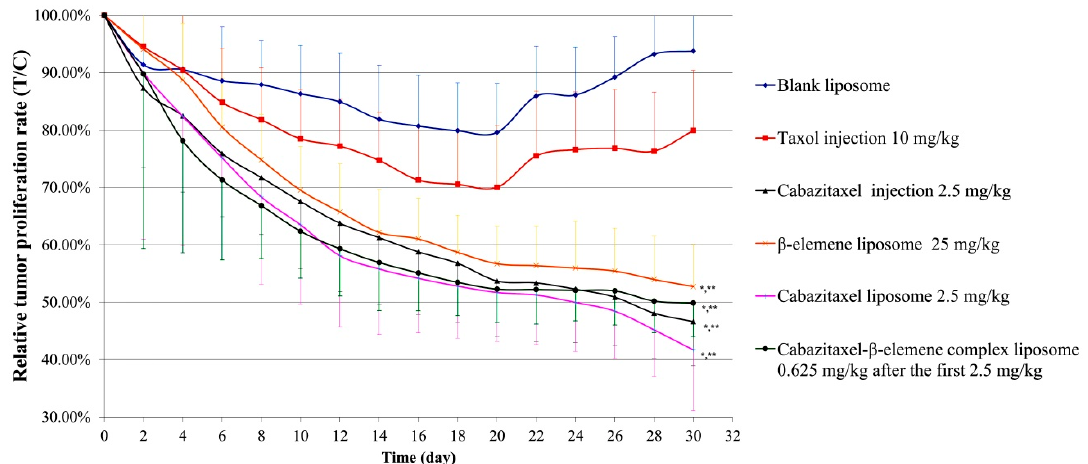
Figure 3. The relative tumor proliferation rate of these liposomes. *Compared with the 5% glucose group, there was a statistically significant difference ( p < 0.01). **Compared with the taxol injection group, there was a statistically significant difference ( p < 0.01). Compared with the cabazitaxel injection group, there was no statistically significant difference for the group with cabazitaxel liposome, β -elemene liposome or the complex liposome, respectively. The results of the statistics parameter of the relative tumor proliferation rate were the same as those of the relative tumor volume.